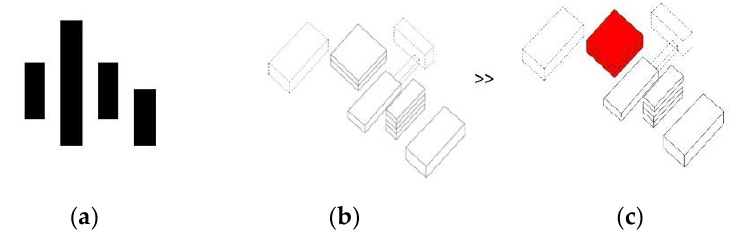
Figure 2. Free-standing detached pavilions: cluster/campus layout. ( a ) Planimetric scheme; ( b ) Axonometric scheme; ( c ) Axonometric scheme with the minimum area that must be dedicated to the infectious disease section indicated red.